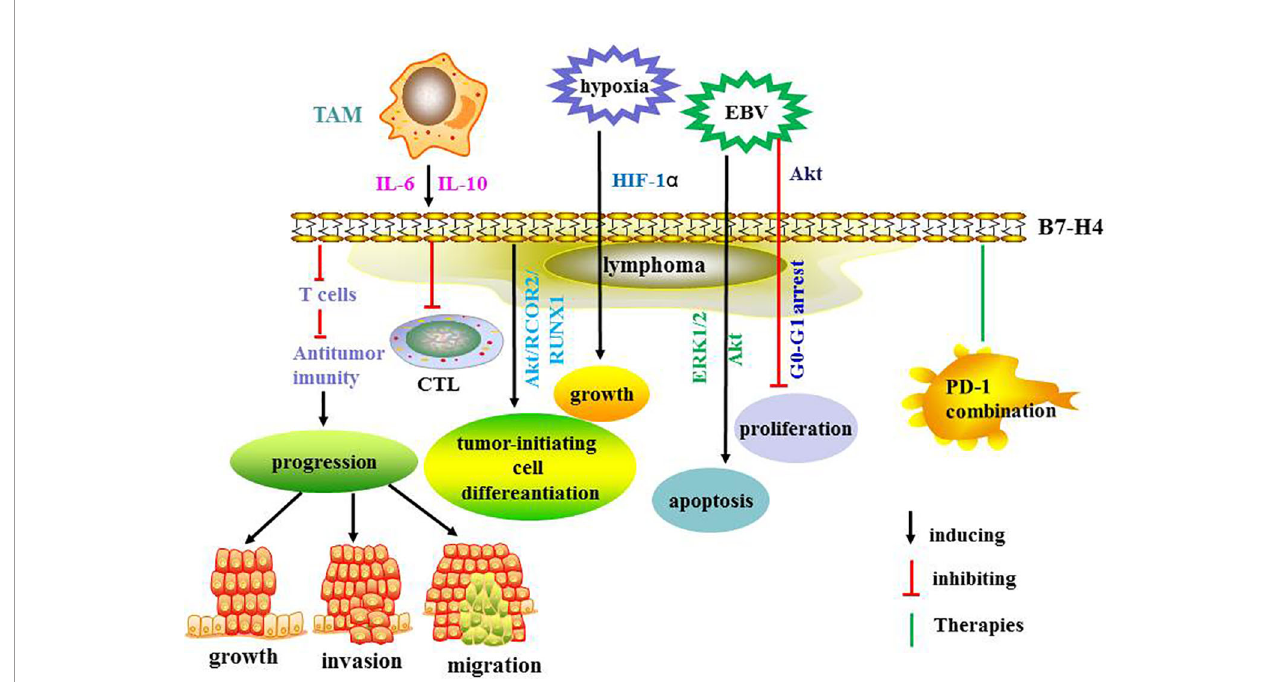
FIGURE 4 | The regulatory mechanisms and therapies targeting